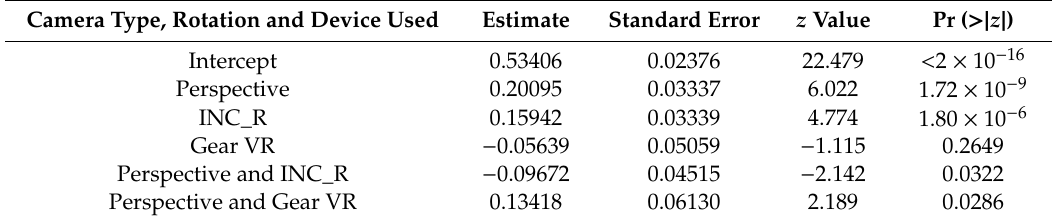
Table 32. Logistic regression analysis results with the variables camera type, rotation, and device used, allowing interactions of